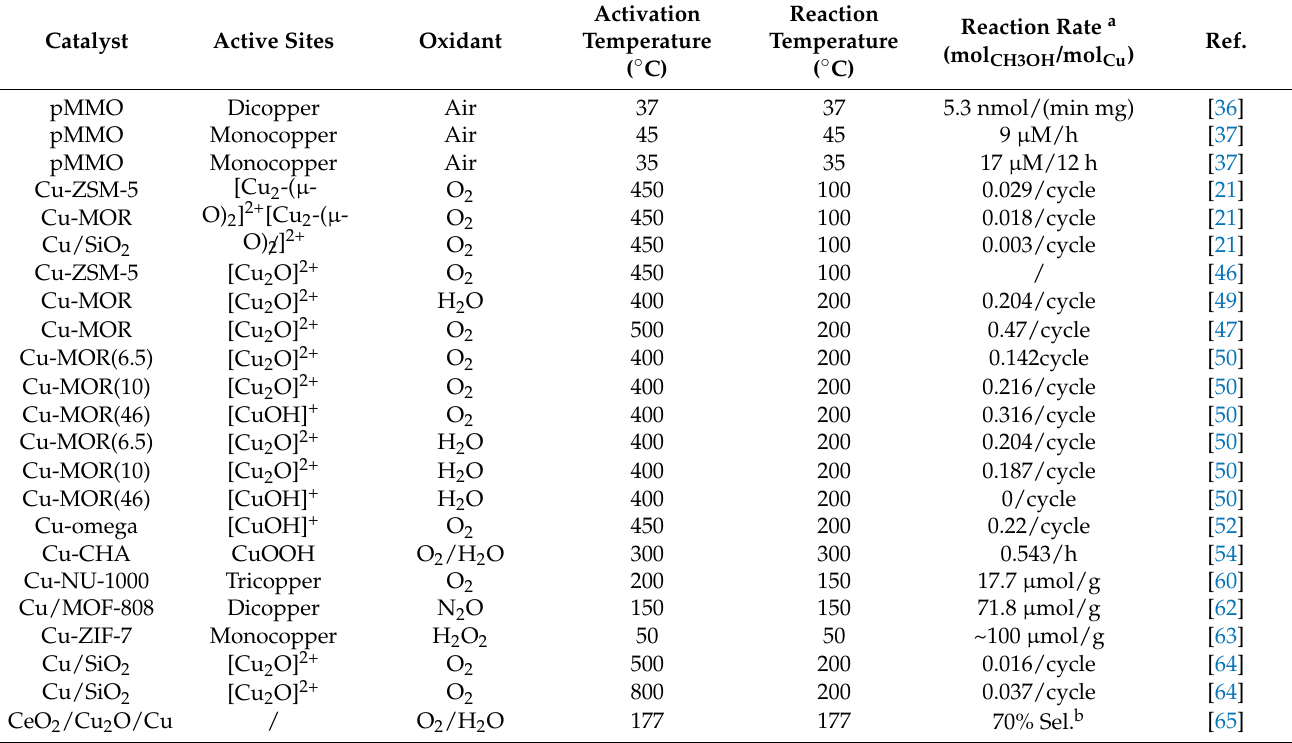
Table 1. Catalytic performances of different catalysts for the direct conversion of methane to